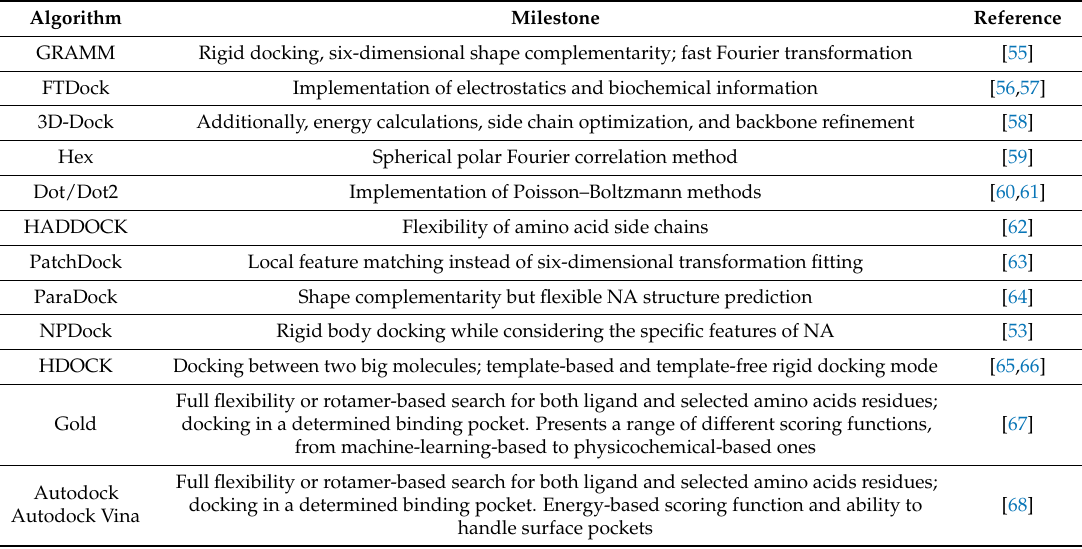
Table 1. A chronological overview of docking algorithms according to the mode of